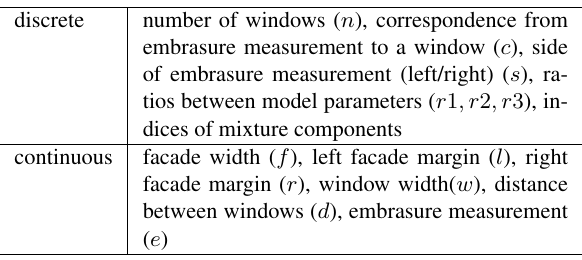
Table 2: parameters modelling a row of